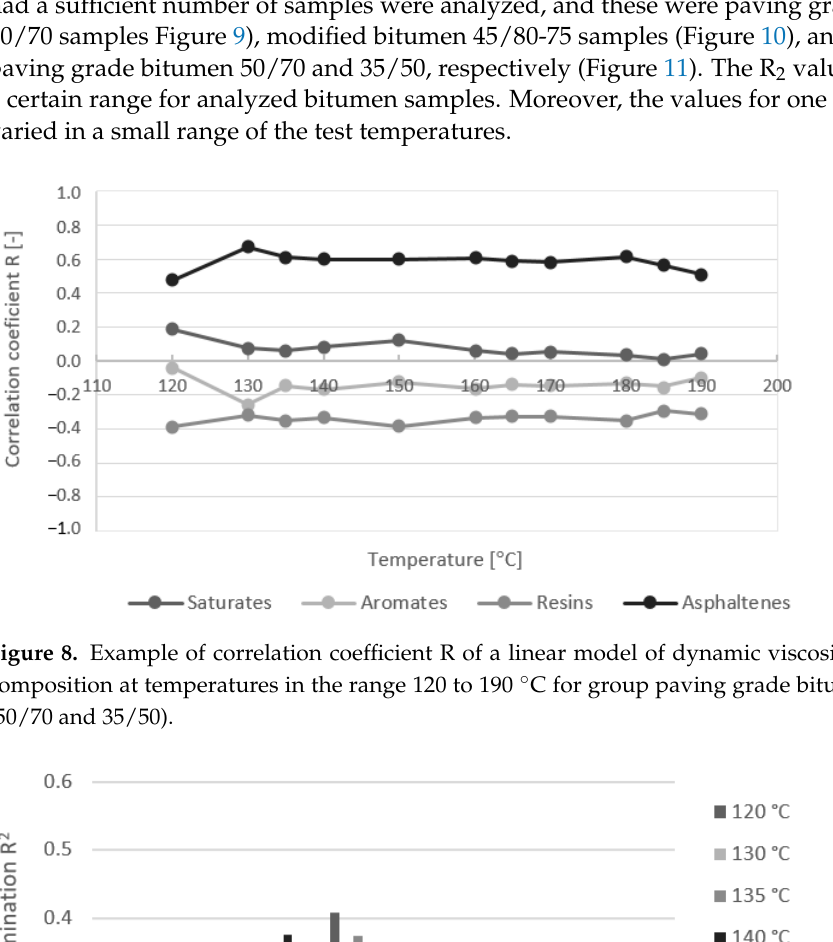
Figure 10. Coefficient of determination of linear model of dynamic viscosity and SARA composi- tion at temperatures in the range 120 to 190 °C for group modified bitumen 45/80-75 samples.